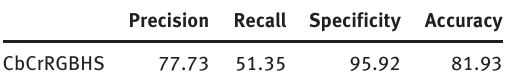
Table 4. Accuracy Results for CbCrRGBHS on the UCD Database.